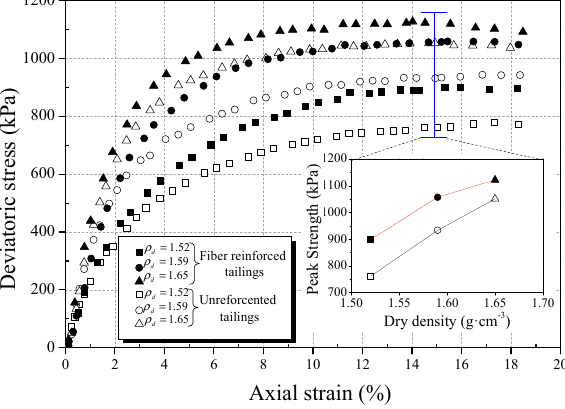
Figure 12. Effect of dry density on mechanical behavior of reinforced tailings sand (0.4 wt% fiber content).